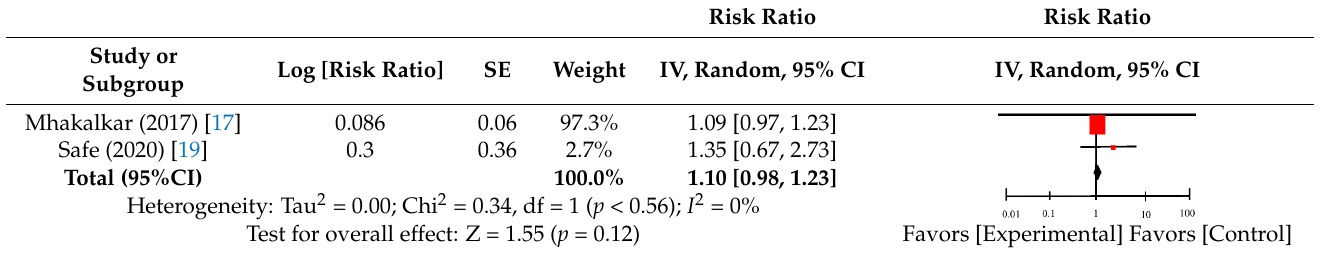
Table 5. Forest plot on sputum culture conversion.